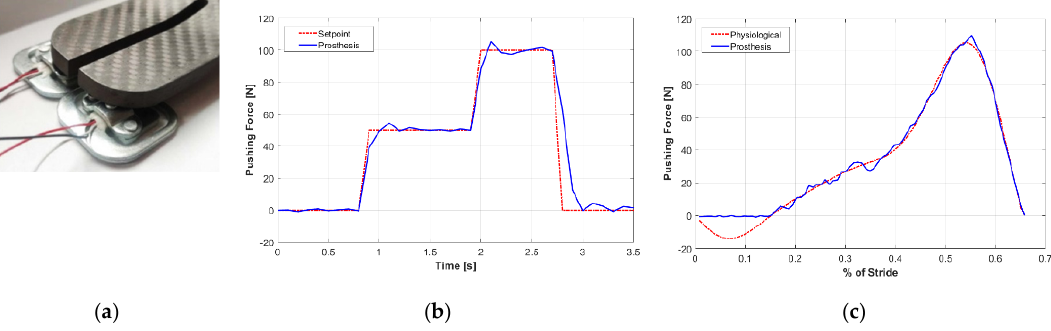
Figure 10. ( a ) Detail of the load cells under the distal parts of the foot of the prosthesis; ( b ) Pushing force in a step response test with the proportional, integrative and derivative (PID) control system; ( c ) Pushing force phisiological vs. prosthesis with the PID control system in the pre-swing phase.